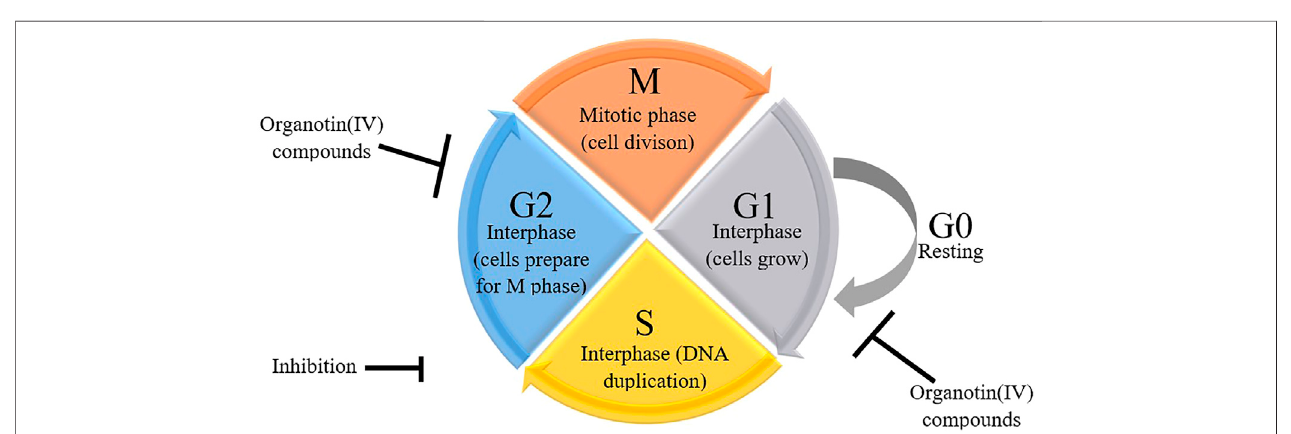
FIGURE 3 | Schematic representation of possible mechanisms of organotin(IV) compounds.